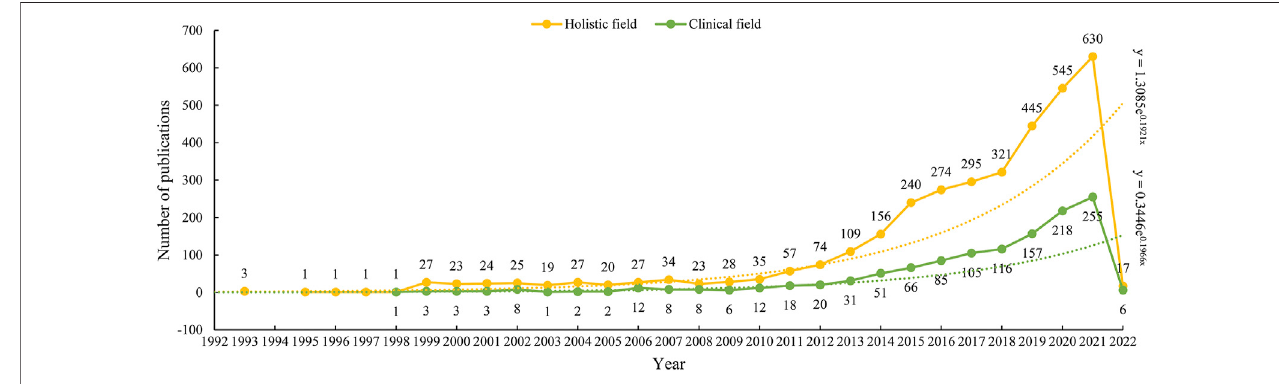
FIGURE 1 | Annual publications of ADC research in the fi eld of solid cancer.